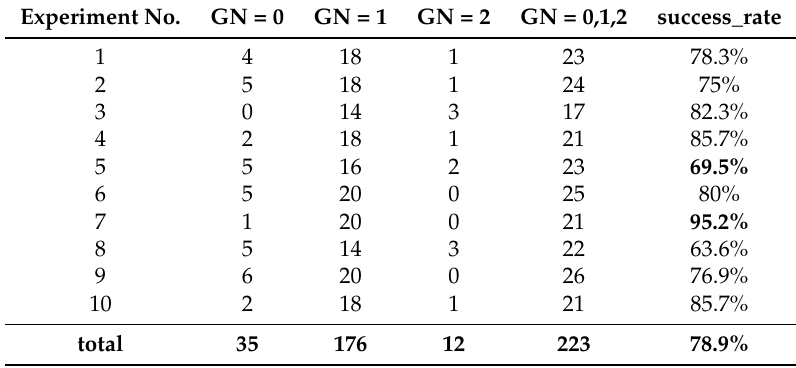
Table 2. Picking the white square towels on the table (GN: the number of towels grasped). Experiment No.